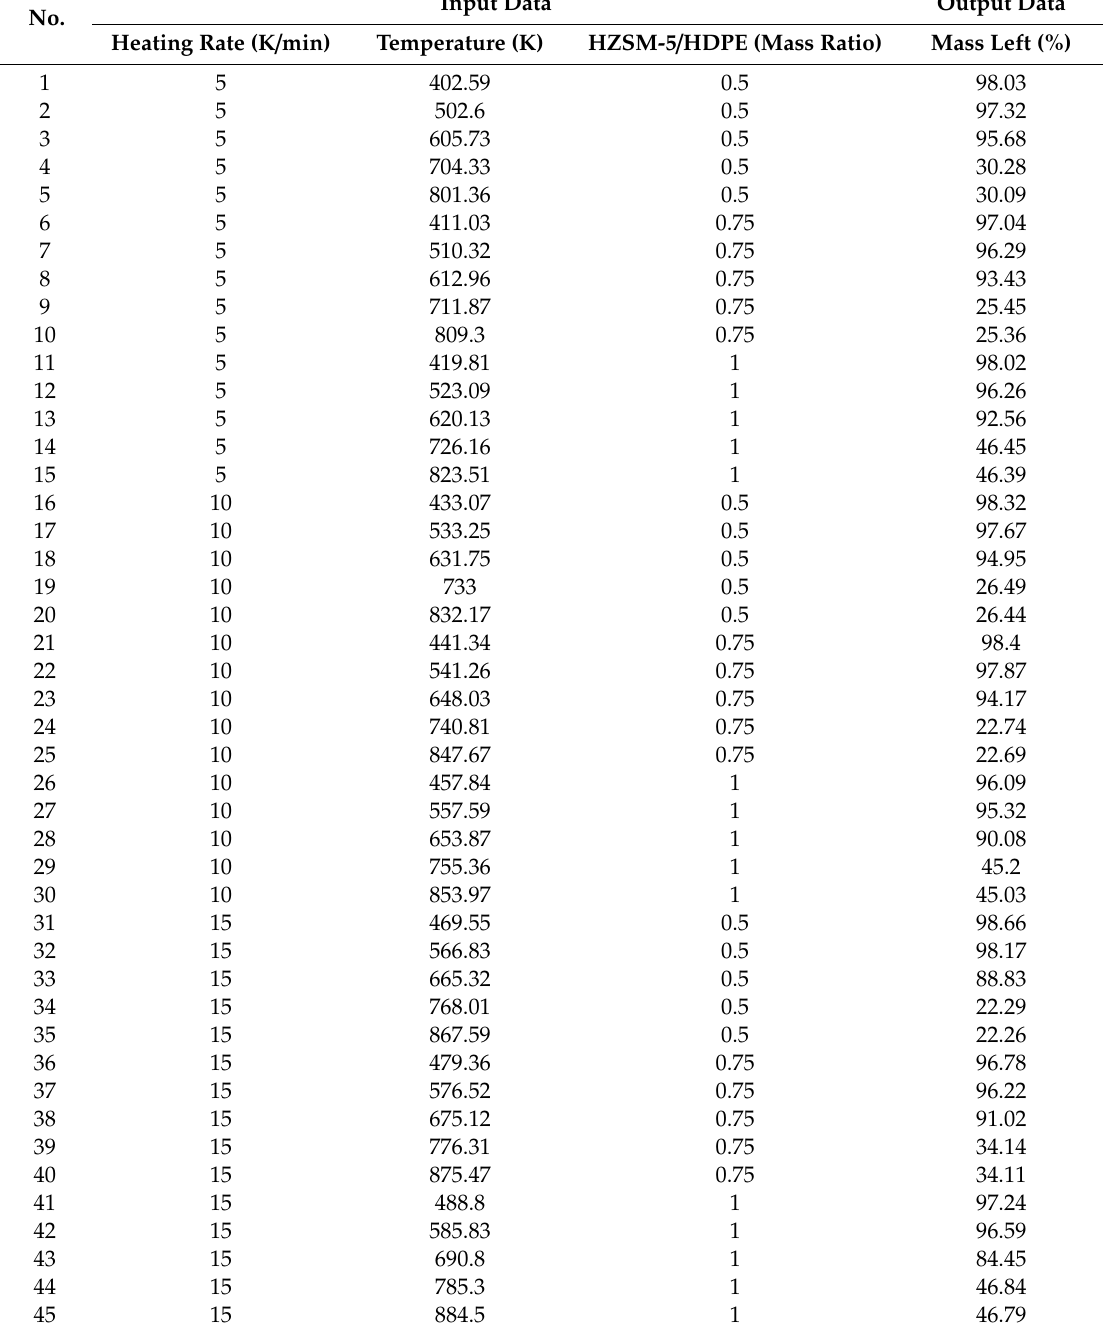
Table 10. ANN-predicted results of the new input data.